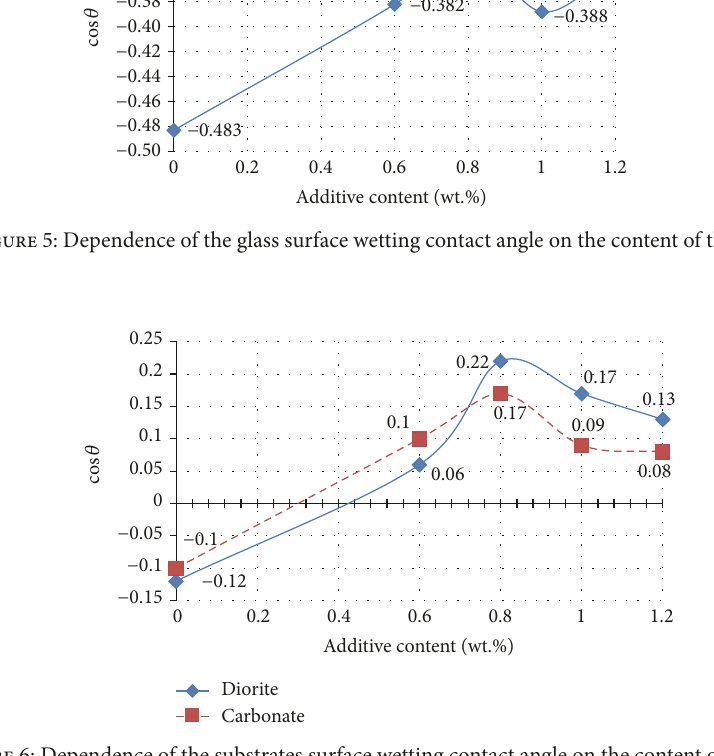
Figure 6: Dependence of the substrates surface wetting contact angle on the content of the